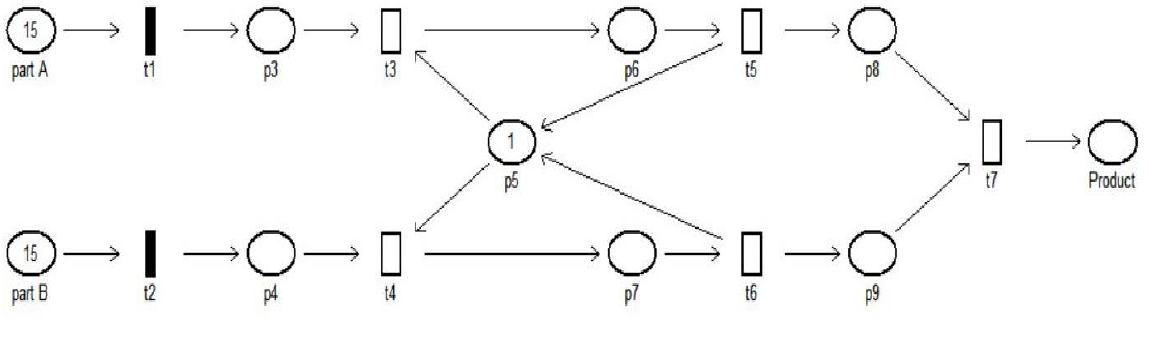
Figure 2: Petri net design of the system